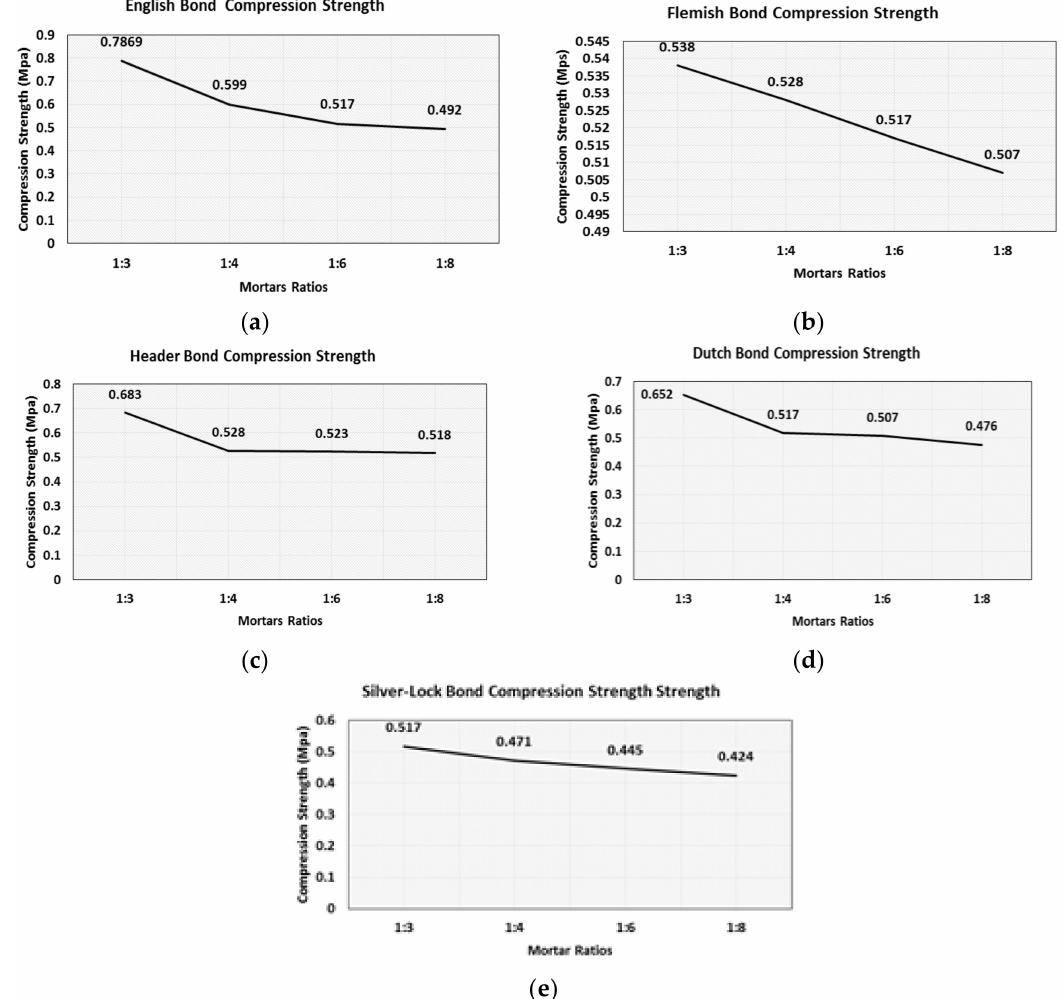
Figure 6. Compressive strength for the ( a ) English bond; ( b ) Flemish bond; ( c ) header bond; ( d ) Dutch bond; and ( e ) silver-lock